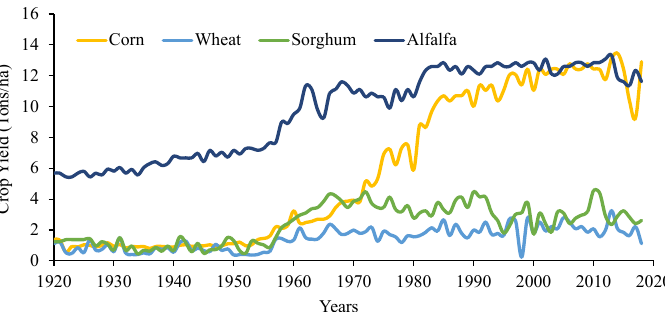
Figure 3. Historical crop yields of corn, wheat, sorghum, and alfalfa from 1920 to 2019 (USDA-NASS). Table 1. Growing season of selected crops (source: USDA-NASS, 2018 and OSE, 2012). Crops